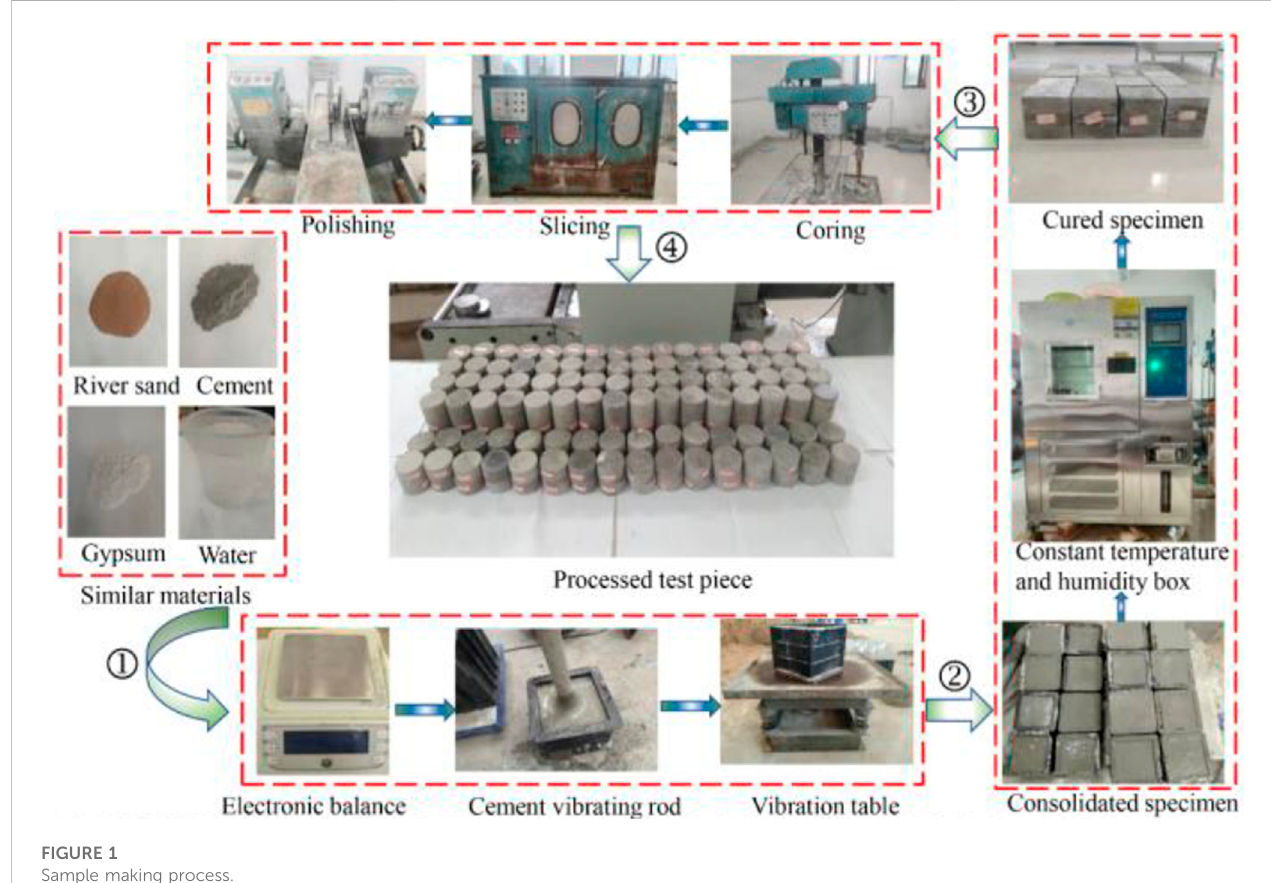
FIGURE 1 Sample making